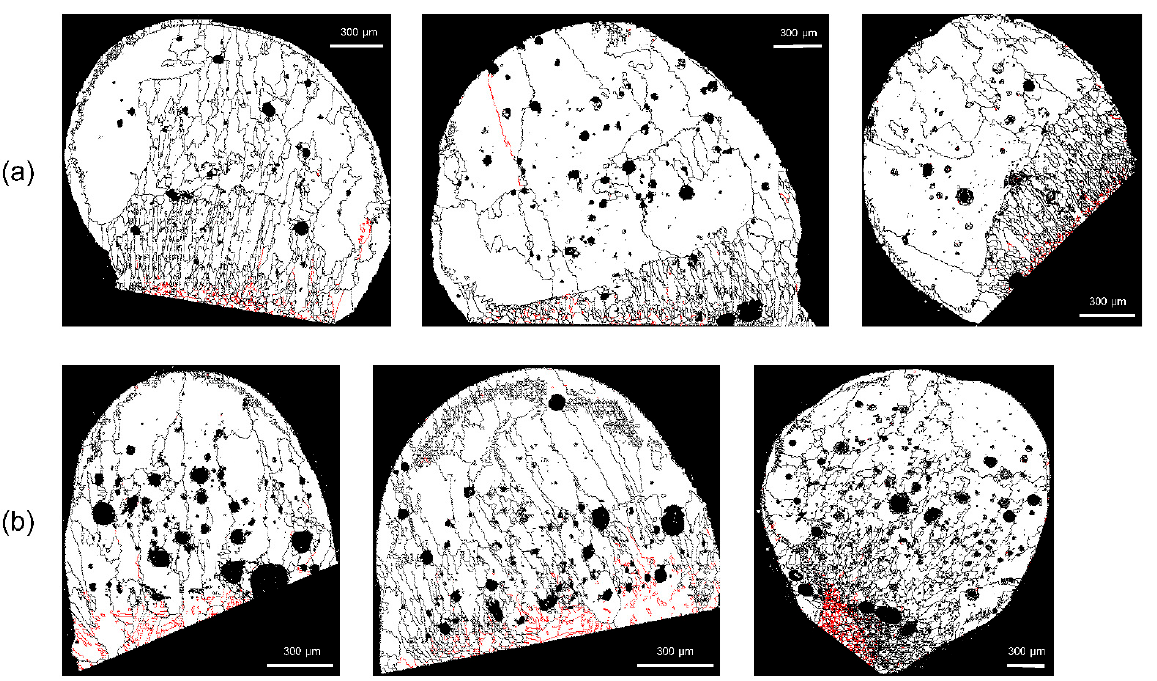
Figure 7. Distribution of Σ 3 boundaries (red line) in the molten marks: ( a ) SAB-600 and ( b ) SAB-900.